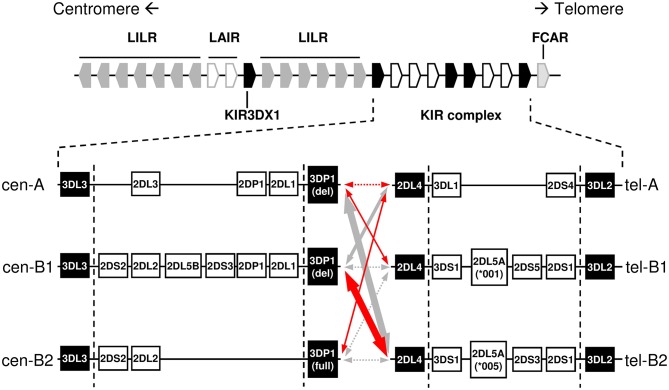
Centromeric and telomeric KIR-gene haplotypes commonly observed in Caucasoids, and their linkage disequilibrium in Spanish individuals. Positive and negative relative linkage disequilibrium values are represented with red and gray arrows, respectively. Dotted lines indicate non-statistically significant LD, whilst thickness of solid lines indicates the level of statistical significance (p < 0.05/0.01/0.0001). Conserved “framework” genes are represented as solid boxes. Genes and intergenic spaces are not depicted to scale.